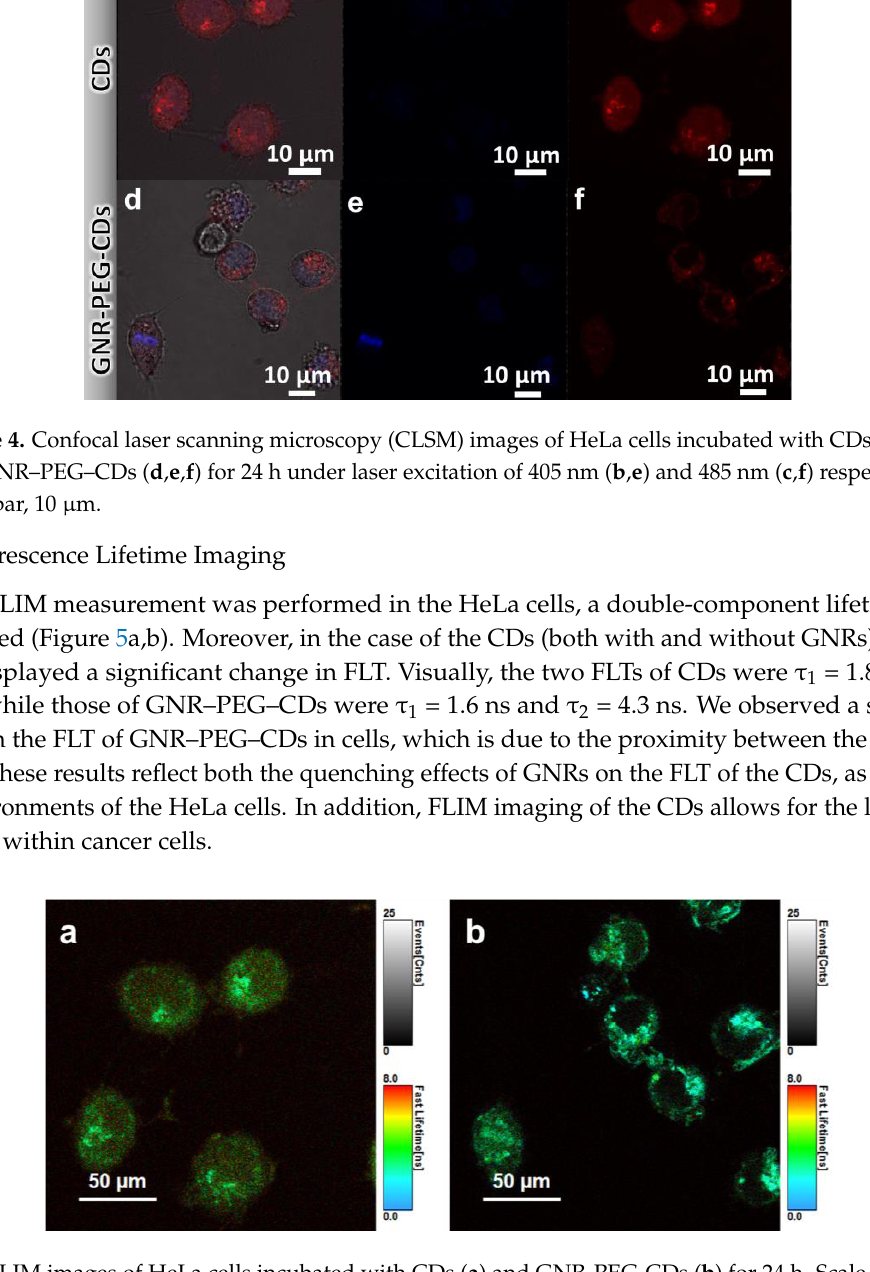
Figure 5. FLIM images of HeLa cells incubated with CDs ( a ) and GNR-PEG-CDs ( b ) for 24 h. Scale bar, 50 µ